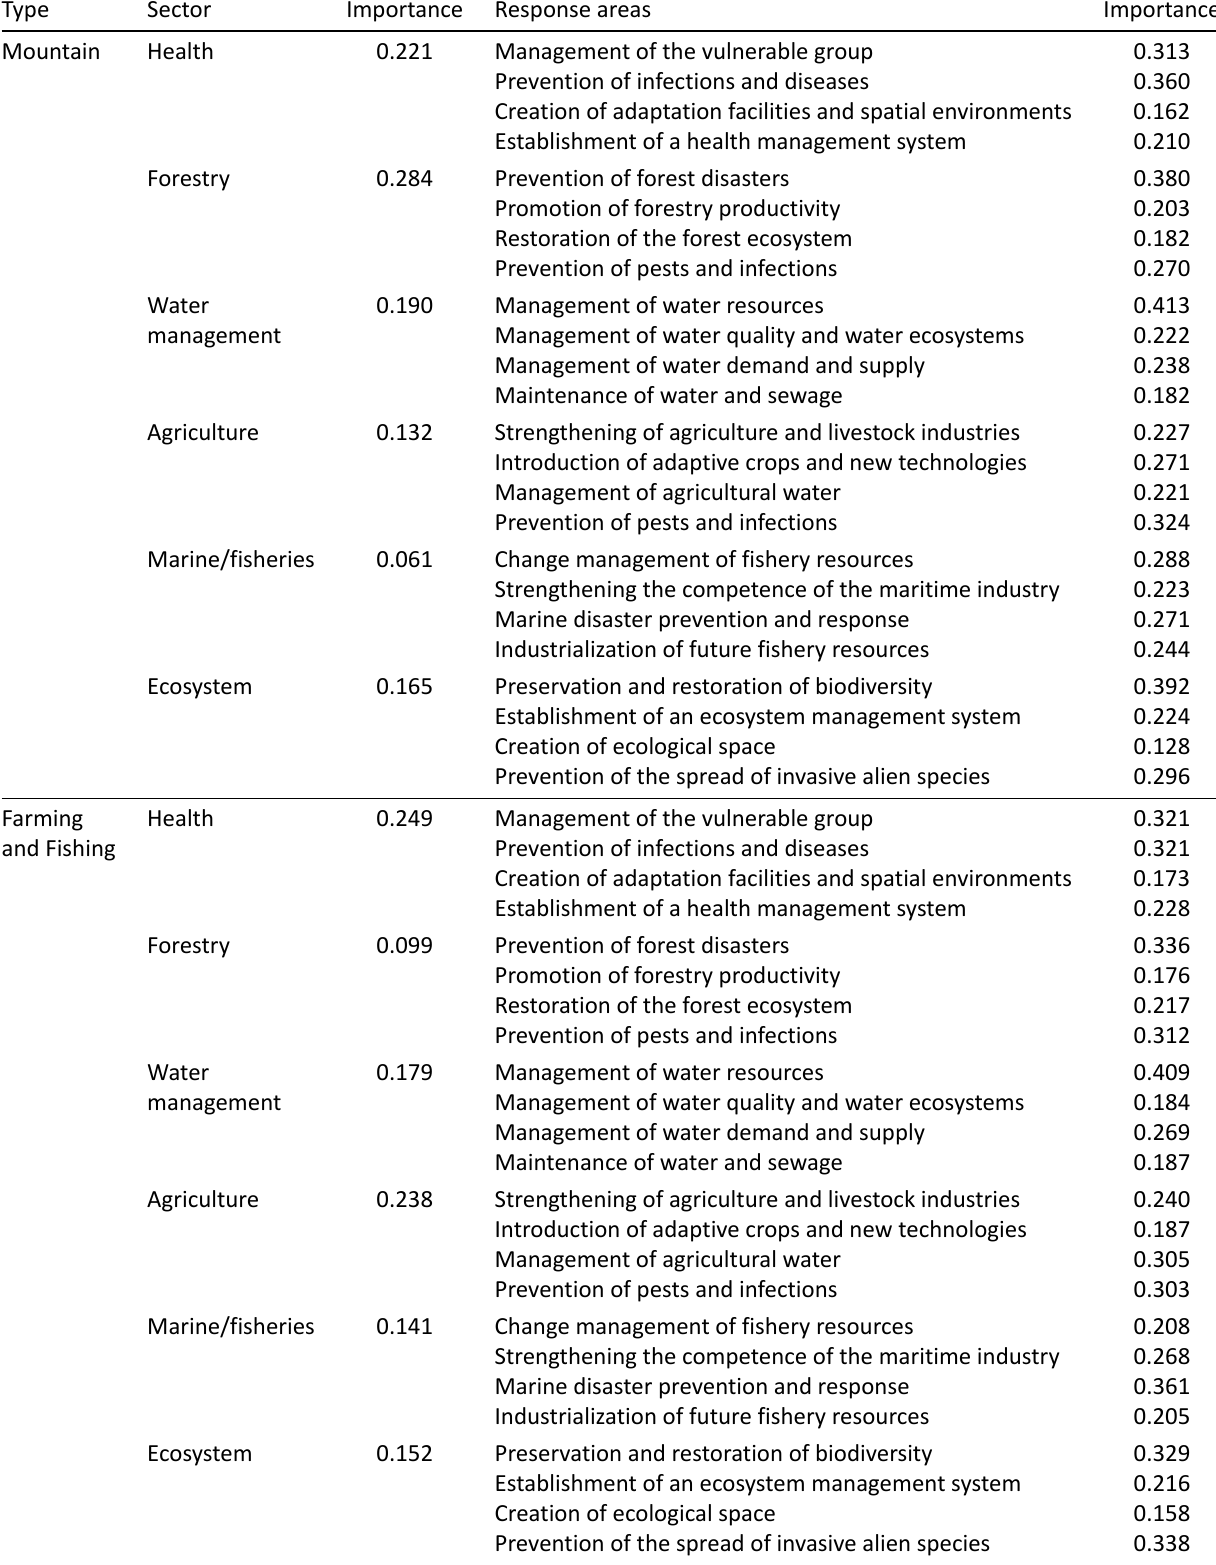
Table 7. (Cont.) Importance of the sector and response areas of heat wave adaptation policies by municipality type.